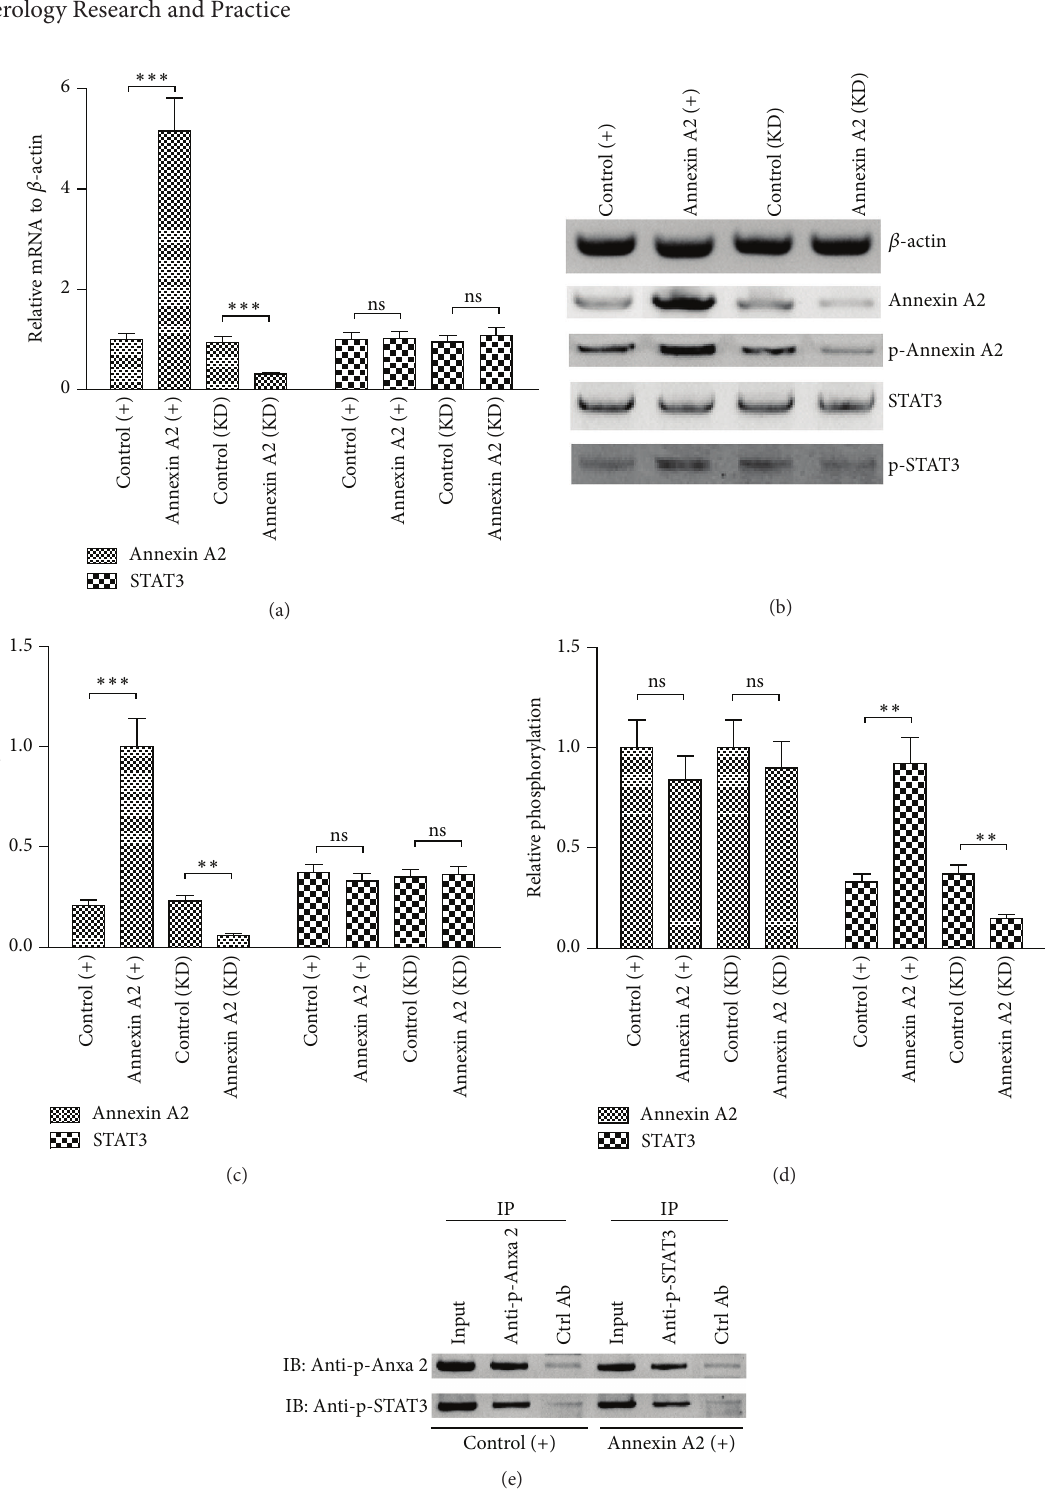
Figure2:AnnexinA2positivelymodulatedtheSTAT3phosphorylationinCaco-2cells.(a)RelativemRNAlevelofAnnexinA2andSTAT3in the Caco-2 cells, which were transfected with pRC/CMV-Annexin A2-FLAG (Annexin A2 (+)), pcRC/CMV (Control (+)), siRNAi-Annexin A2 (Annexin A2 (KD)), or control siRNA (control (KD)) for 24 hours; (b) western blotting assay of Annexin A2 with or without Tyrosine 23 phosphorylation and STAT3 with or without Tyrosine 705 phosphorylation in the Caco-2 cell groups of Annexin A2 (+), control (+), Annexin A2 (KD), and control (KD); (c) relative protein levels of Annexin A2 and STAT3 without phosphorylation to 𝛽 -actin in the abovementioned groups; (d) levels of phosphorylated forms to non-phosphorylated forms of Annexin A2 and STAT3 in the abovementioned groups; (e) coimmunoprecipitation analysis of the interaction between the phosphorylated Annexin A2 (Tyr 23) and the phosphorylated STAT3 (Tyr 705). Data was averaged for triple independent experiments, ∗∗ represented 𝑝 < 0.01 , ∗ ∗ ∗ represented 𝑝 < 0.001 , and ns represented no